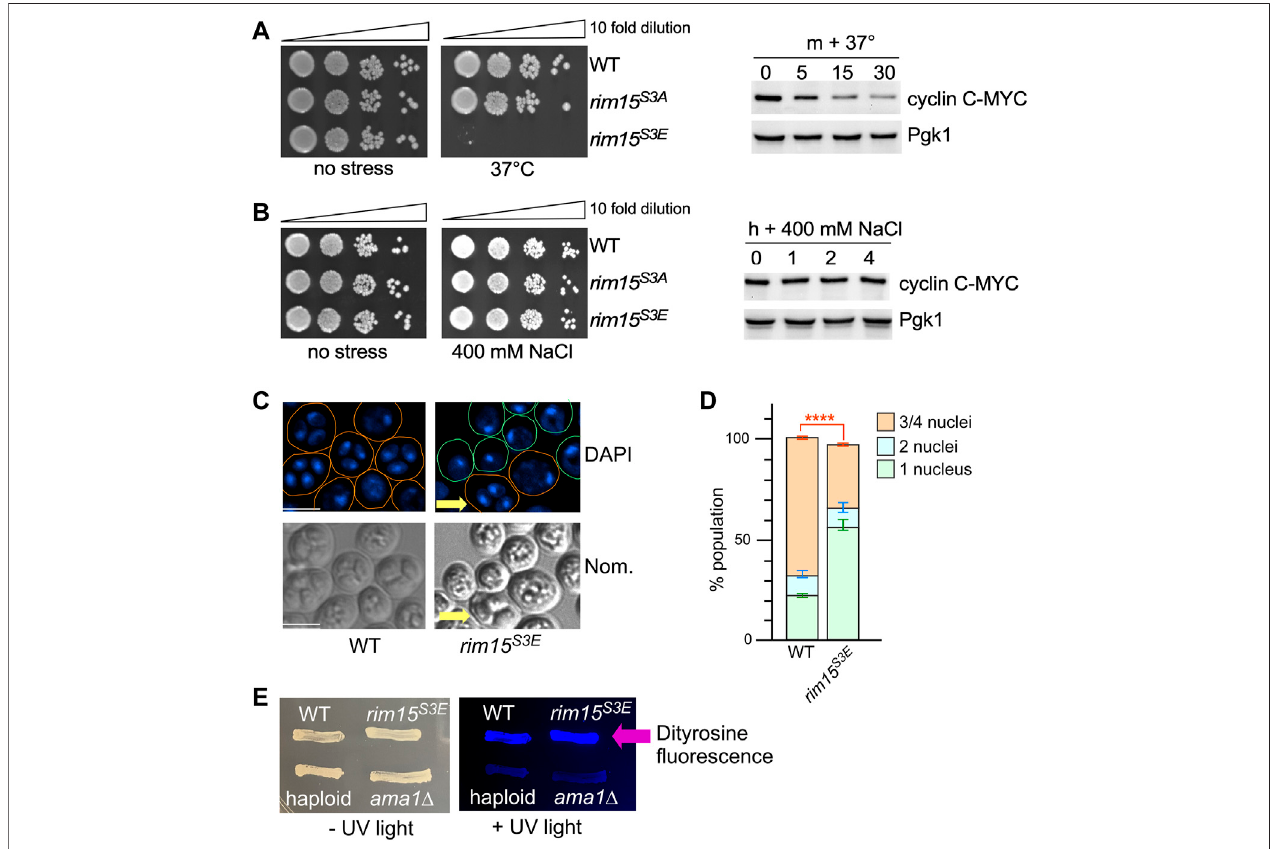
FIGURE 9 | Removal of Cdk8 phosphorylation of Rim15 is required to survive a subset of cellular stress. (A,B) Left hand panel. Quiescent survival assays of the strains shown following 2 h treatment with the indicated stress. Mid-log cultures were treated as described in methods. Ten-fold serial dilutions of the cells were then plated onto YPD plates and growth recorded after 48 h at 30 ° C. Right hand panel. Western blot analysis of cyclin C following the indicated stress. Wild type cells harboring cyclin C-MYC (pKC337) were grown to mid-log before being treated with the stress shown. Timepoints were taken for analysis as indicated. Pgk1 was used as a loading control. (C) Fluorescence microcopy of wild type (RSY335) and Rim15 S3E (RSY2684) diploids after 3 days on sporulation plates. Scale bar: 5 µm. Nom. — Nomarskiimaging. (D) Quanti fi cationofthenumberofnuclei.Threeindependentdiploidculturesand200cellswerescored/culture.**** p ≤ 0.001. (E) Sporewall formationwasassayedusingthedityrosine fl uorescenceassayinthediploids (WT, Rim15 S3E , ama1 Δ (RSY562))andWThaploid (RSY332)strains.Cellswereexamined by UV light after 7 days on SPIII plates.